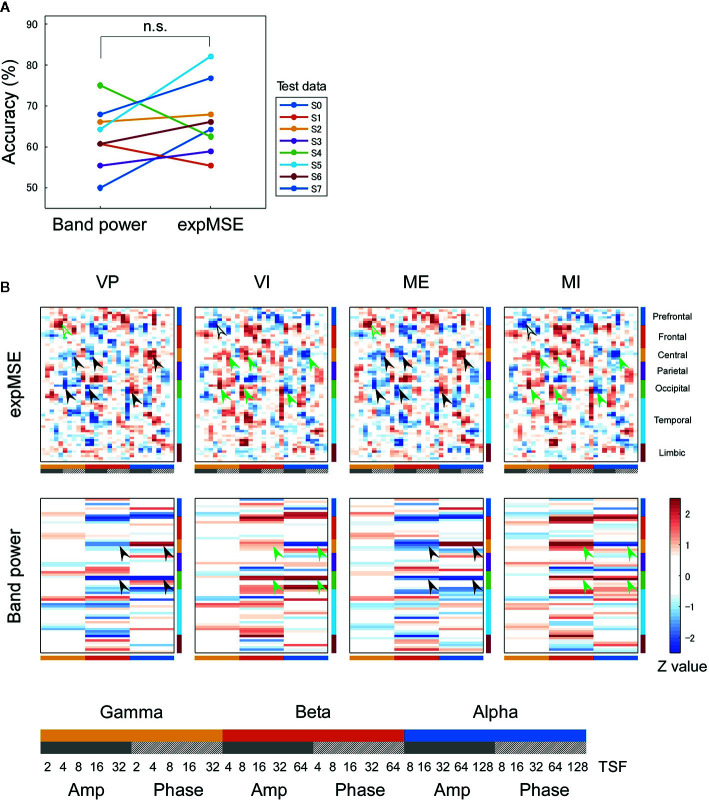
Inter-subject decoding of imagery behavior. (A) Decoding accuracies compared by band power and expMSE. Each color corresponds to a subject used for test data. n.s., not significant. (B) Task-related sensitivity maps. Upper and lower panels respectively portray maps for the expMSE and band power: VP, visual perception; VI, visual imagery; ME, motor execution; MI, motor imagery; black filled arrow, modality-specific sensitivity; green filled arrow, inverted sensitivity in the modality-specific regions; black open arrow, modality-independent sensitivity; green open arrow, inverted sensitivity in the modality-independent regions. At the bottom are details of the horizontal axes: frequency × component (Amp/Phase) × TSF; Amp, amplitude expMSE; Phase, phase expMSE.